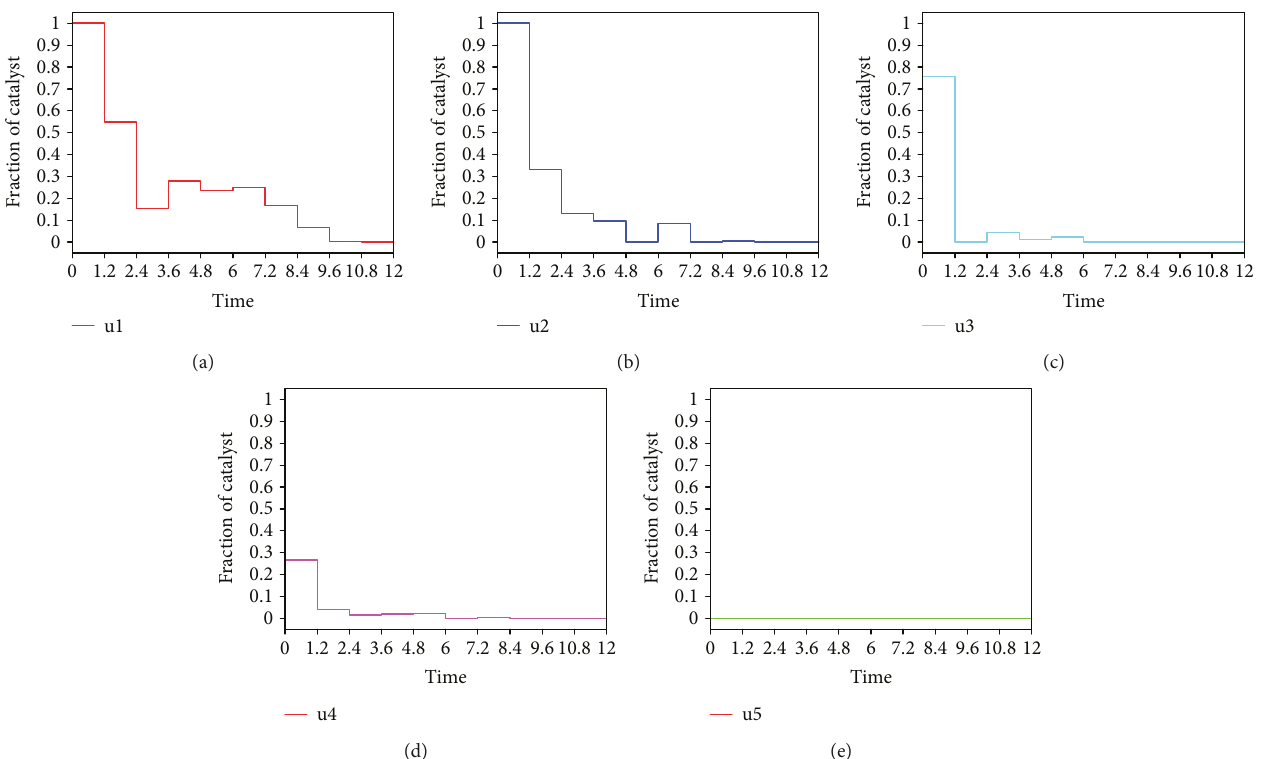
Figure 13: The Pareto optimal trajectories of fi ve selected solutions for case I. (a) u1, (b) u2, (c) u3, (d) u4, and (e) u5. Table 6: Five solutions selected from the front for case